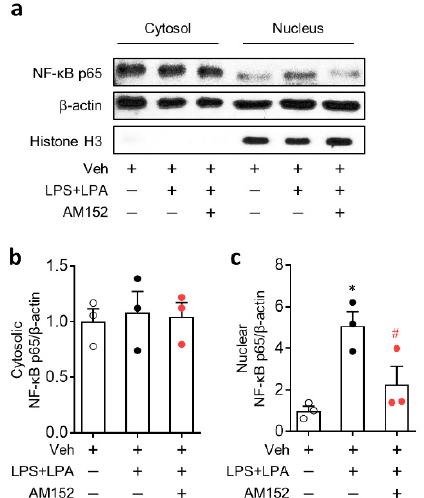
Figure 7. LPA 1 antagonist inhibits LPA-induced nuclear factor- κ B (NF- κ B) activation in LPS-primed BMDMs. Cells were primed with LPS (500 ng/mL) for 4 h, followed by an exposure to LPA (1 µM) for 1 h. NF- κ B activation was determined by comparing expression levels of cytosolic and nuclear NF- κ B p65 based on Western blot analysis. Representative Western blots of cytosolic and nuclear NF- κ B p65 ( a ) and quantification of NF- κ B p65 translocation into the nucleus ( b,c ) are shown. n = 3 per group. * p < 0.05 versus control BMDMs (Veh). # p < 0.05 versus stimulated BMDMs (LPS + LPA).